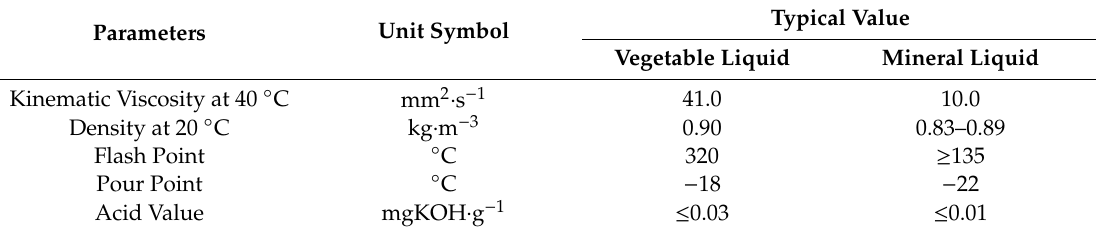
Figure 2. X-ray di ff raction pattern of C 60 after surface modification. Figure 2. X-ray diffraction pattern of C 60 after surface modification. Table 1. Basic physicochemical properties of insulating